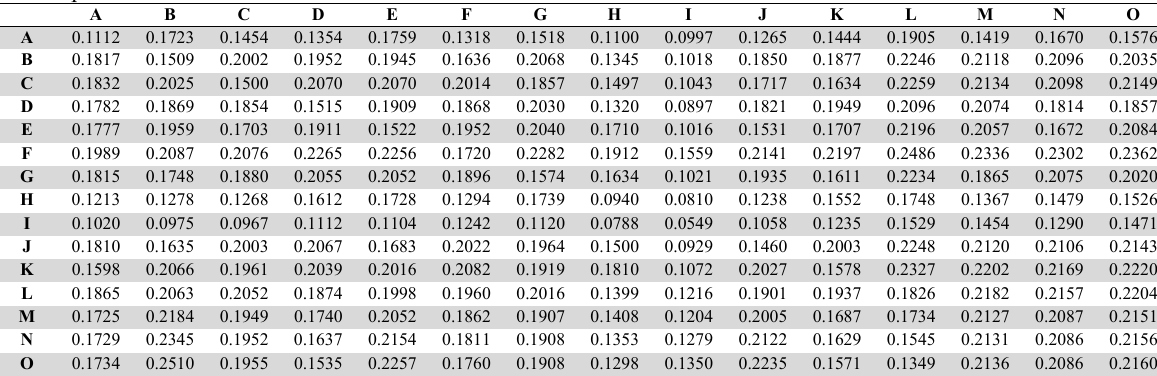
The crisp total-relation matrix A